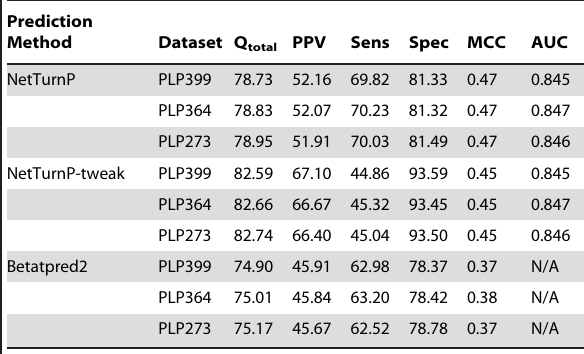
Table 3. Evaluation of b -turn prediction on new PLP